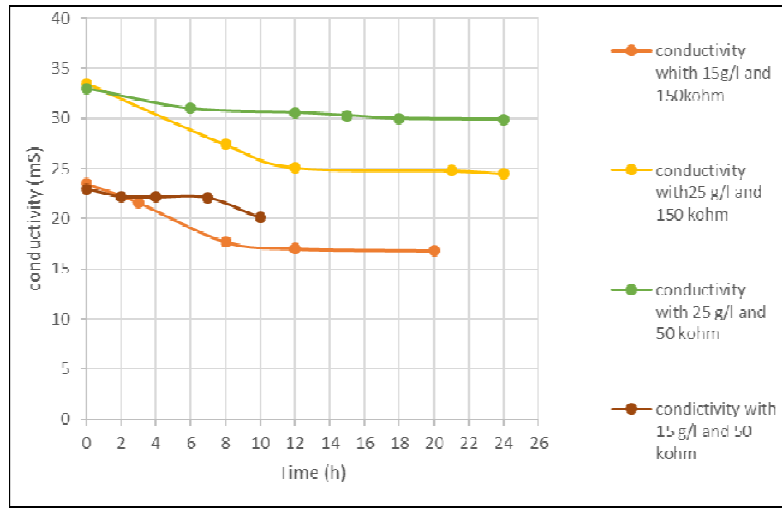
Fig. 4. Shown the conductivity of the MDC without using mixing in the desalination chamber.